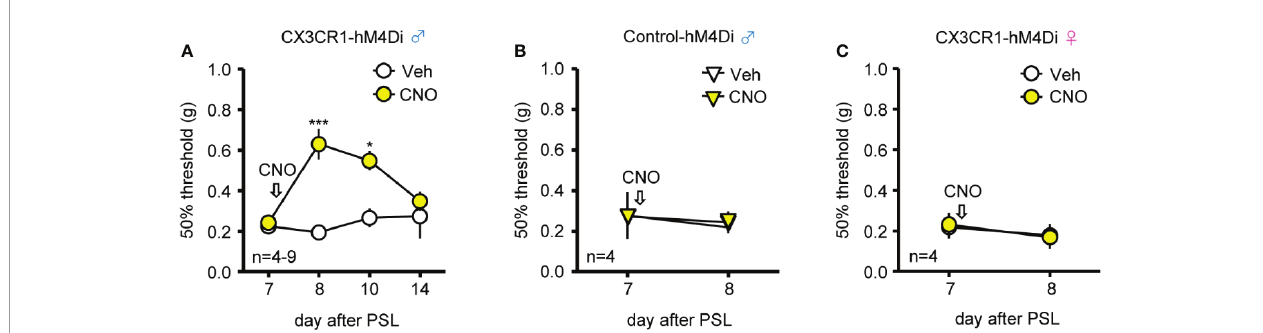
FIGURE 3 | Relief of mechanical allodynia after PSL by intrathecal CNO in male CX3CR1-hM4Di mice. The mice were subjected to PSL, and CNO (20 nmol) or Veh was intrathecally (i.t.) administered after pain assessment as indicated by arrows. The 50% paw withdrawal threshold was assessed by the up – down method using the von Frey test. (A , B) Effect of CNO on the 50% paw withdrawal threshold in the ipsilateral side of male CX3CR1-hM4Di and Control-hM4Di mice after PSL. (C) No effect of CNO on mechanical allodynia in the ipsilateral side of female CX3CR1-hM4Di mice after PSL. Data are presented as mean ± S.E.M. n = 4-9. p***< 0.001, p* < 0.05 vs